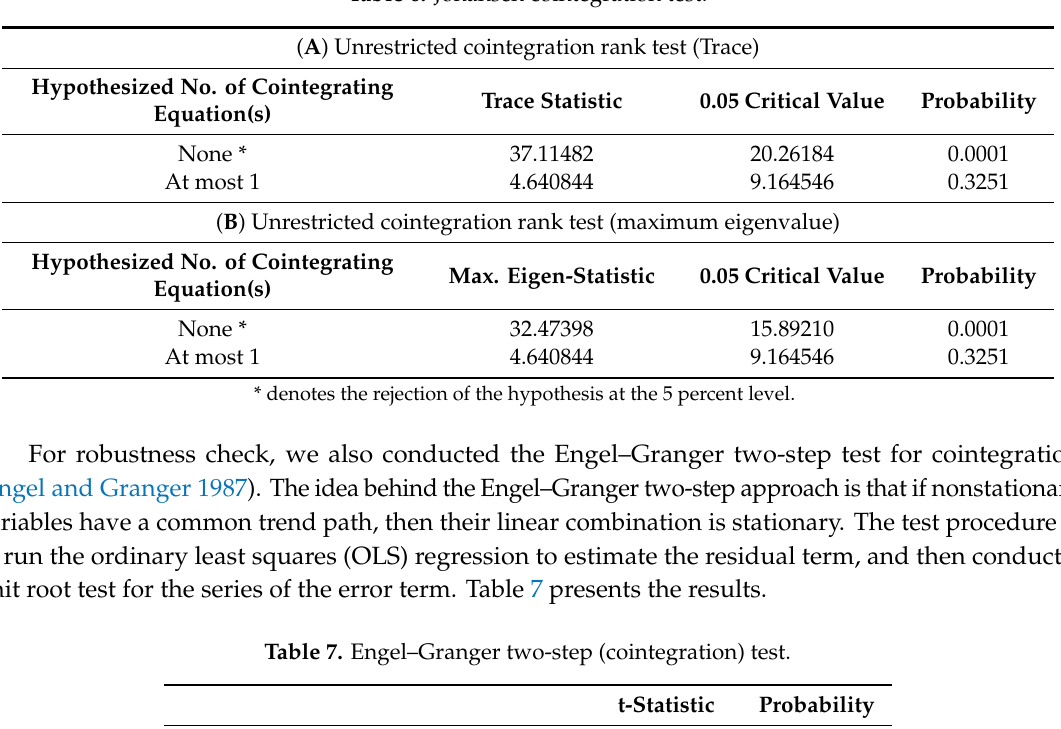
Table 6. Johansen cointegration test.